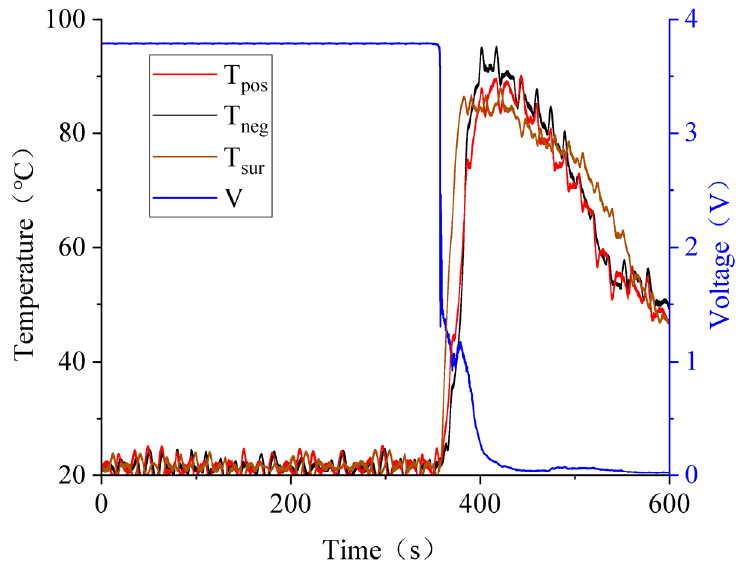
Figure 10. Forty percent SOC state battery curve.